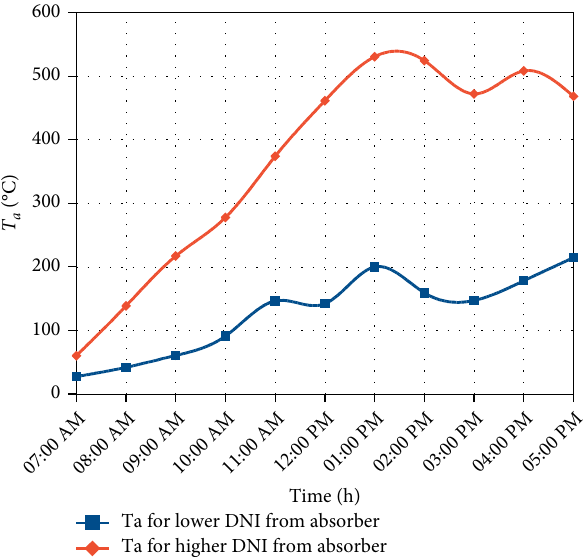
Figure 7: Comparison of experimental data with simulation results of temperature of thermal storage at 1 s. Time step and 0.1 m space step with 0.0048 kg/s mass flow rate of hot air. (sim. is simulation and ex. is experimental)